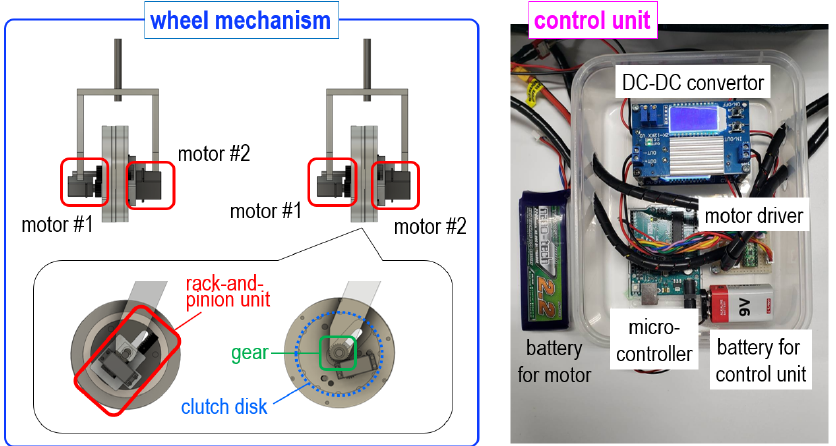
Figure 11. Details on the motor installation ( left ) of the wheel-mechanism prototype and the electronic components ( right ) of the control unit.